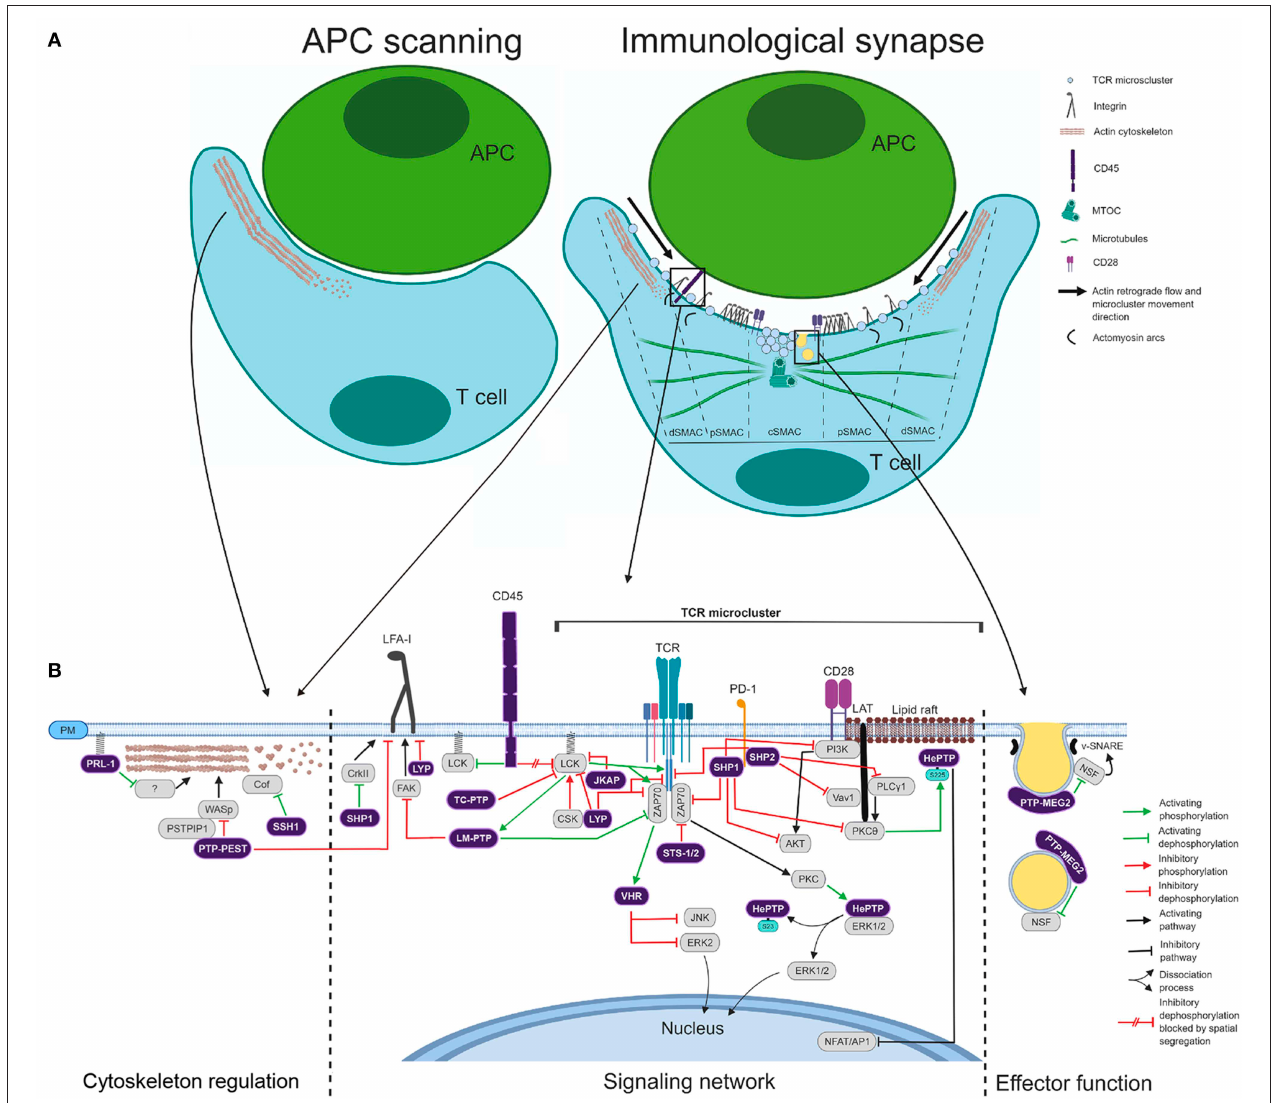
FIGURE 2 | Coordinated action of PTPs during IS assembly. (A) Schematic of the APC T-cell scanning and IS assembly. The main molecules, cytoskeleton components, and endomembranes delivered at the IS are depicted. The cSMAC, pSMAC, and dSMAC are indicated. Right legend indicates different molecules and synapse elements. (B) Schematic of the regulatory role of PTPs in cytoskeleton, signaling network and effector function. Right legend indicates functional connectors used.